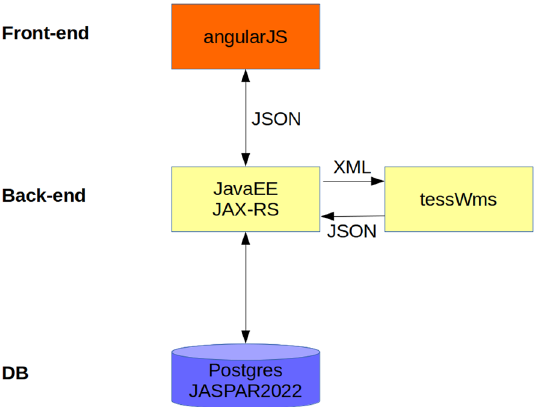
Figure 2. Architecture of AIModules. The three layers (front-end, back-end, DB) and the flow of information are